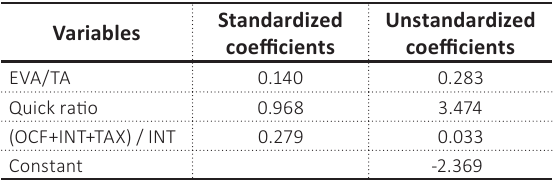
Table 4. Coefficients of the discriminant